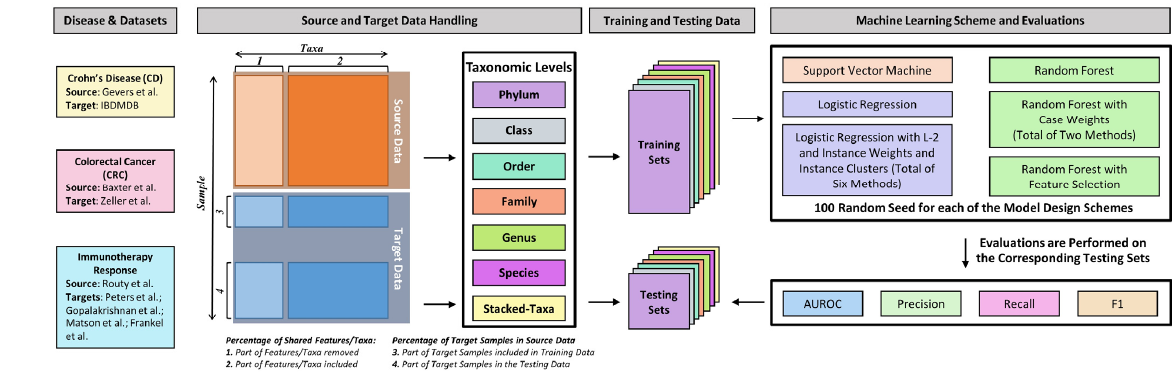
Figure 1. Leveraging scheme workflow.